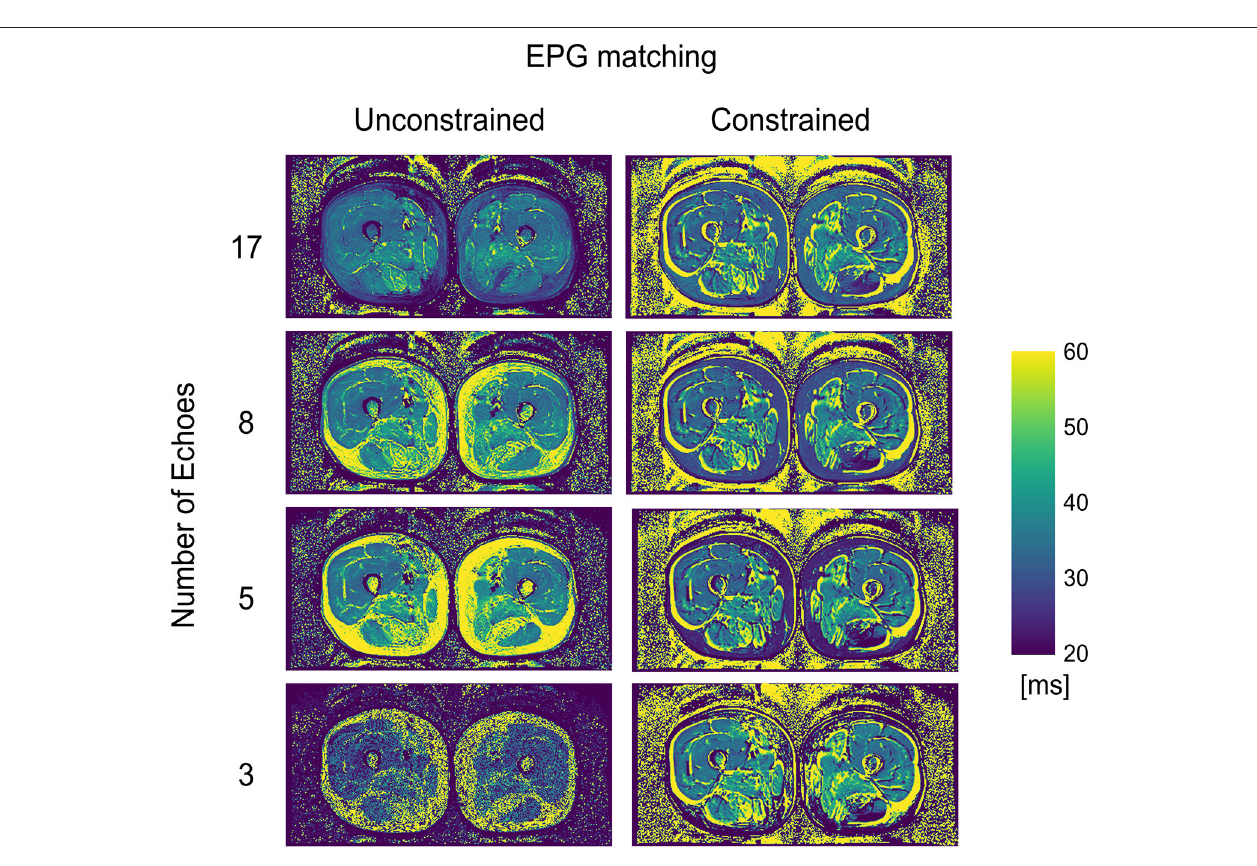
Conversely, the correlation was significantly negative ( r = − 0.71, p < 0.001) for the unconstrained fitting with 17 echoes, and for the constrained fitting of 5 and 8, but not 17 echoes ( r = −